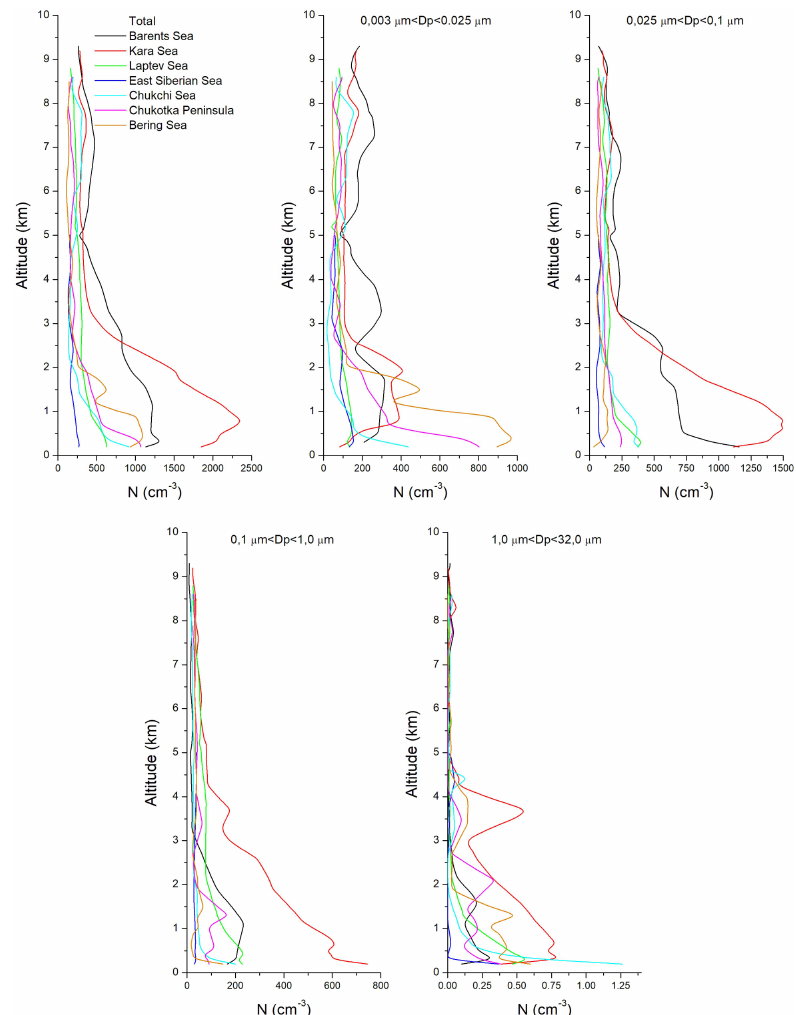
Figure 14. Average vertical profiles of the total, nucleation, Aitken, accumulation, and coarse mode particle number density over different regions of the Russian Arctic in September 2020.